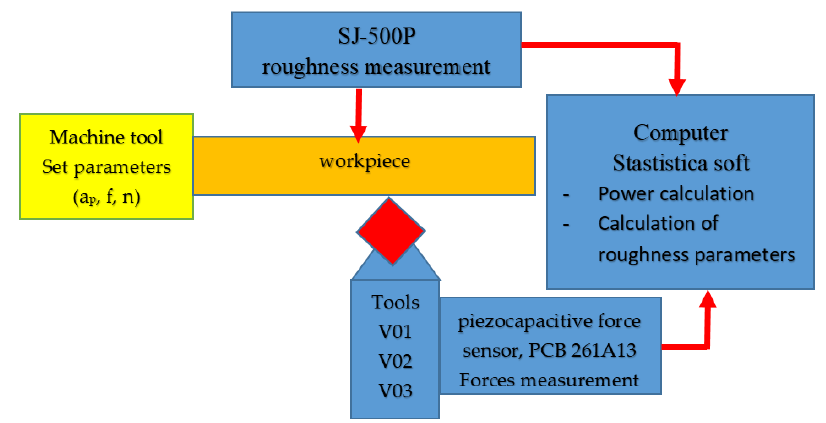
Figure 5. Experimental Setup.